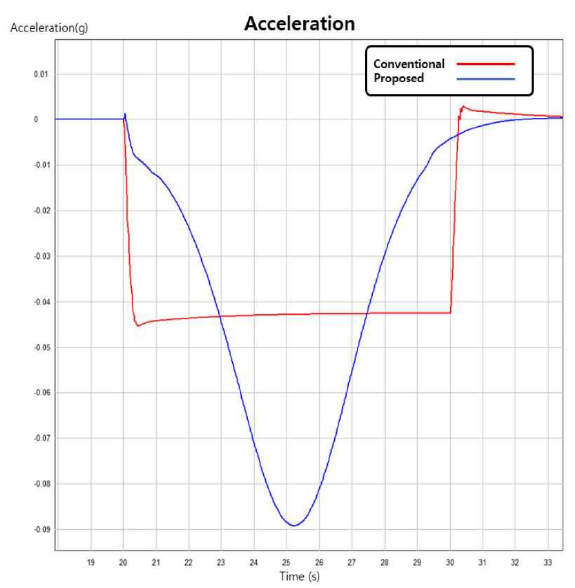
Figure 20. Acceleration comparison when changing speed from 30 to 15 km/h. The maximum deceleration obtained by CRBS was − 0.09 g, and that of the conventional method was − 0.04